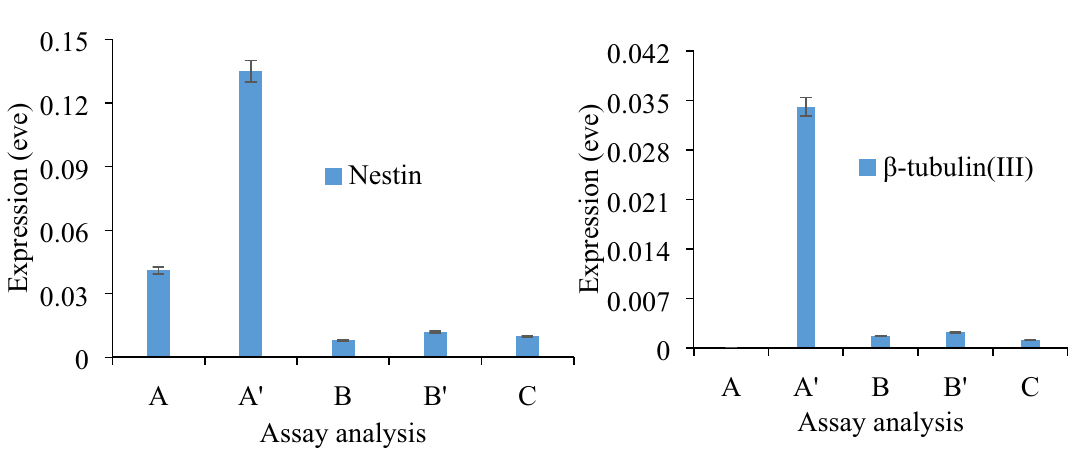
Figure 3. Nestin and β-tubulin(III) assay analyses (50.0 ng mL −1 ) for the differentiated NSCs. The data are the average of 5 replicate analyses, standard deviation: ± 0.08, t-value = −2.3, p value = 0.015 for 95% confidence level and 4 degrees of freedom. ( B ), ( B ′ ), and ( C ) untreated cells at different time intervals inside the neuron cells (control), ( A ) and ( A ′ ): treated differentiated cells after 3 days and after passage, respectively and 1:6 ration for the drug extraction and delivery process. Error bars: ± standard deviation (n =